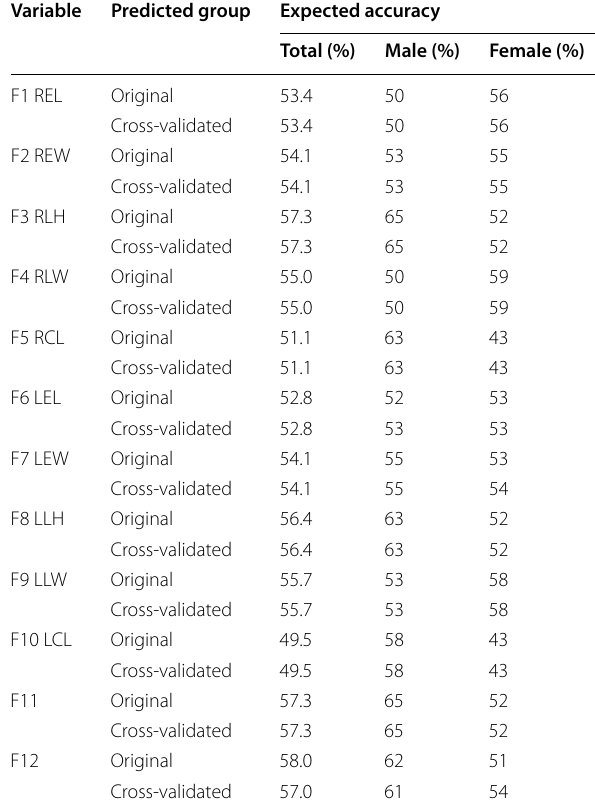
Table 10 Sex prediction accuracy for population-specific stepwise discriminant analysis